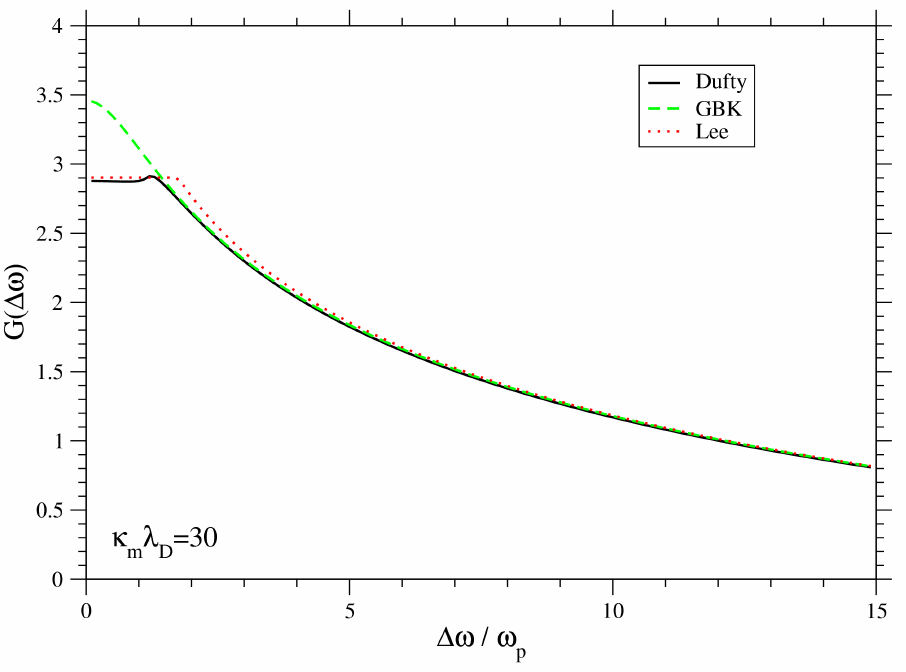
Figure 1. The frequency-dependent part of the electron broadening operator is plotted as a function of the reduced detuning with respect to the center of the line. The dimensionless quantity is evaluated using three different models and approximations (Dufty, GBK, Lee: see text) for κ m λ D = 30. For classical plasmas (low-density and high-temperature limit), the parameter κ m λ D is often very large so that one can further simplify the expression of the G -function. In the limit ∆ ω → 0, it is